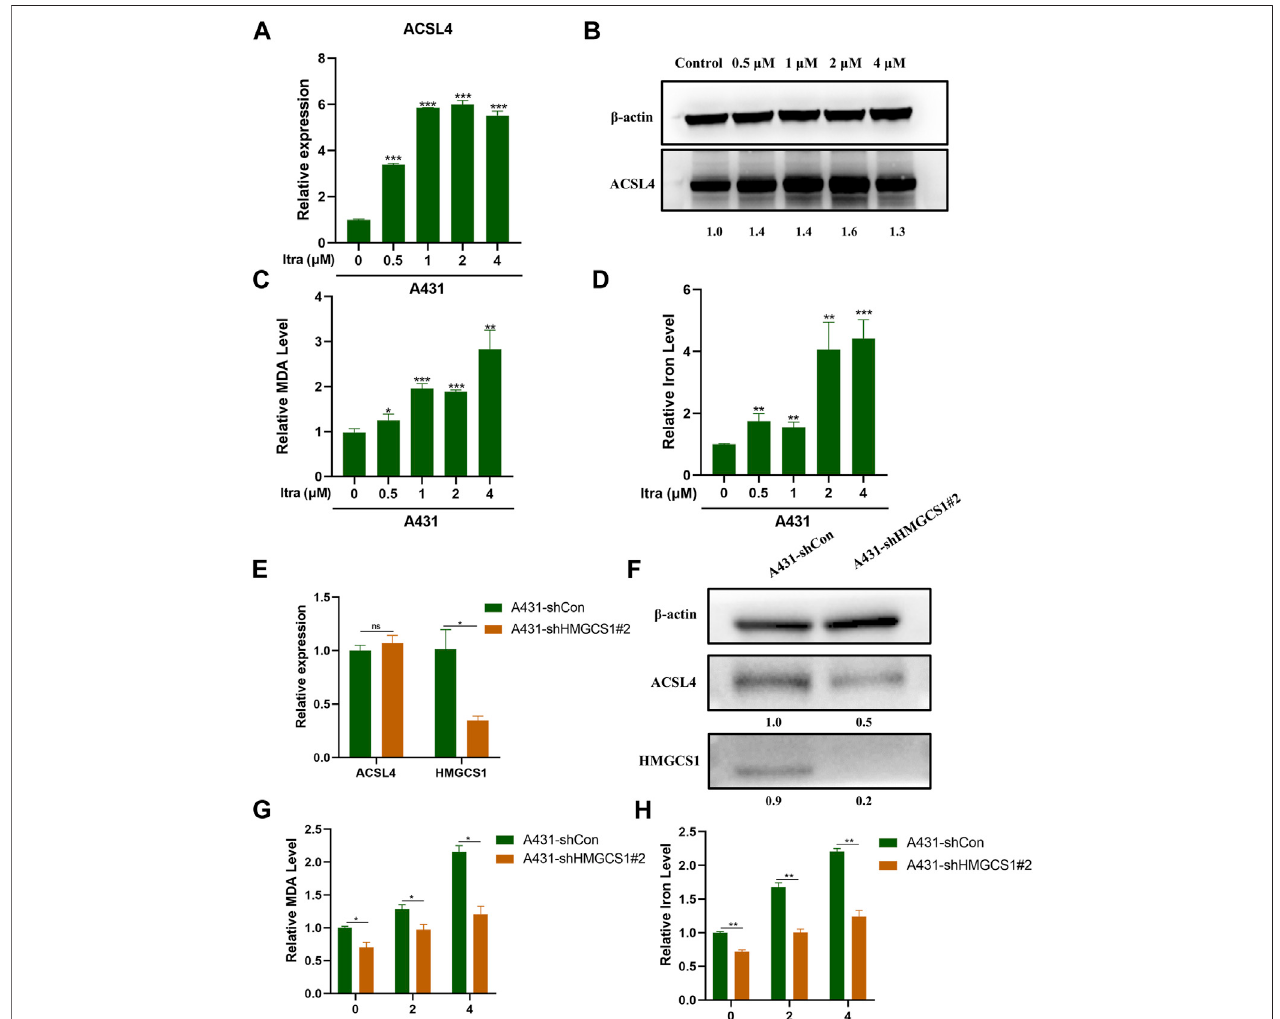
FIGURE 5 | Itraconazole induces ferroptosis through upregulating ACSL4 expression. (A) The relative mRNA expression level of ACSL4 was presented by qRT- PCR. (B) The protein expression level of ACSL4 was presented by western blot. Relative level of MDA (C) and iron (D) in A431 cells treated with itraconazole were investigatedbyspeci fi ckits. (E) TherelativemRNAexpressionlevelofACSL4andHMGCS1inA431sh-ConandA431sh-HMGCS1#2waspresentedbyqRT-PCR. (F) The protein expression level of ACSL4 and HMGCS1 in A431 sh-Con and A431 sh-HMGCS1#2was presented by western blot. Relative level of MDA (G) and